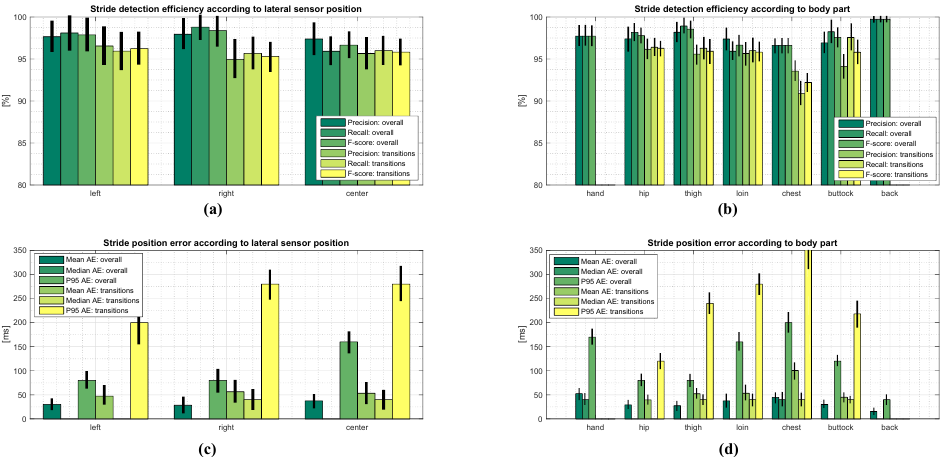
Figure 6. Efficiency and accuracy of stride segmentation according to sensor location. Missing bars represent zero-values. Black bars represent standard deviation. The values are also represented by a green-yellow-red color scale for a better